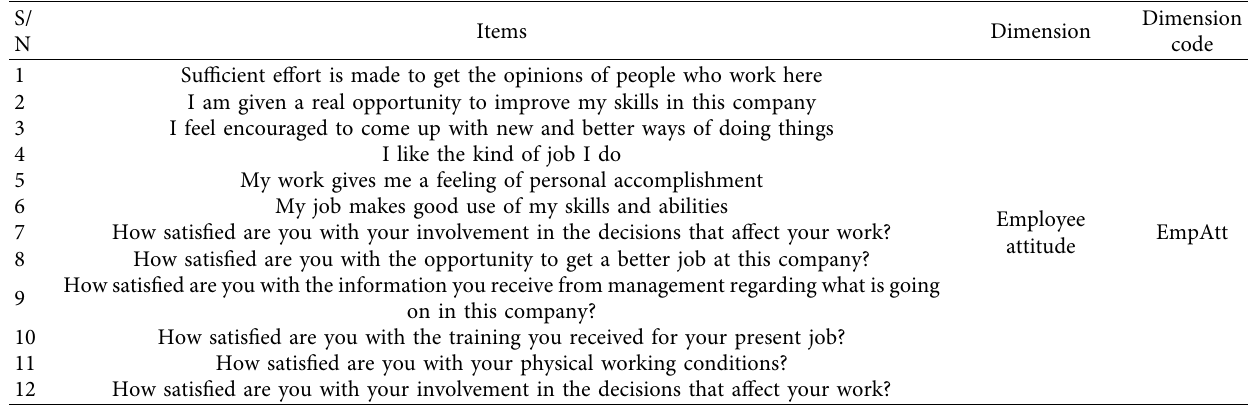
Table 3: Human resources outcomes framework dimension code and